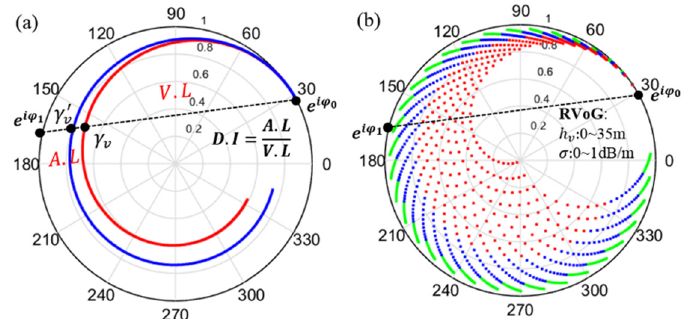
Figure 12. Coherence loci representation in the unit circle. ( a ) Search method of the pure volume coherence; the black finite line between e i ϕ 1 and e i ϕ 0 is the coherence line. γ v is the pure volume coherence without regard to the residual ground scattering error, and γ (cid:48) v is the corresponding improved result. V.L is the length between γ v and e i ϕ 0 , and A.L is the length between e i ϕ 1 and γ v . The red and blue curves are the selected coherence loci before and after using the limited σ , respectively. ( b ) Coherence loci limited by the empirical relationship of D . I and σ ; (where the CHM ranges from 0 to 35 m, and the σ ranges from 0 to 1 dB/m). if 0 < D . I ≤ 0.4, and then σ ∈ [ 0.6,1 ) , as shown in the green region; if 0.4 < D . I ≤ 0.65, and then σ ∈ [ 0.3,0.6 ) , as shown in the blue region; if 𝐷. 𝐼 > 0.65 , and then 𝜎 ∈ (0,0.3) , as shown in the red region.